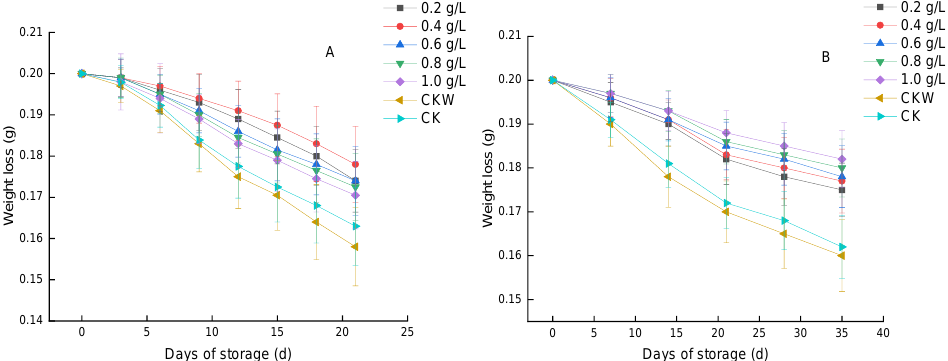
Figure 3. Effects of different Lycium barbarum leaf extract concentrations on weight loss by cherry tomatoes during storage at 20 °C ( A ) and 5 °C ( B ).